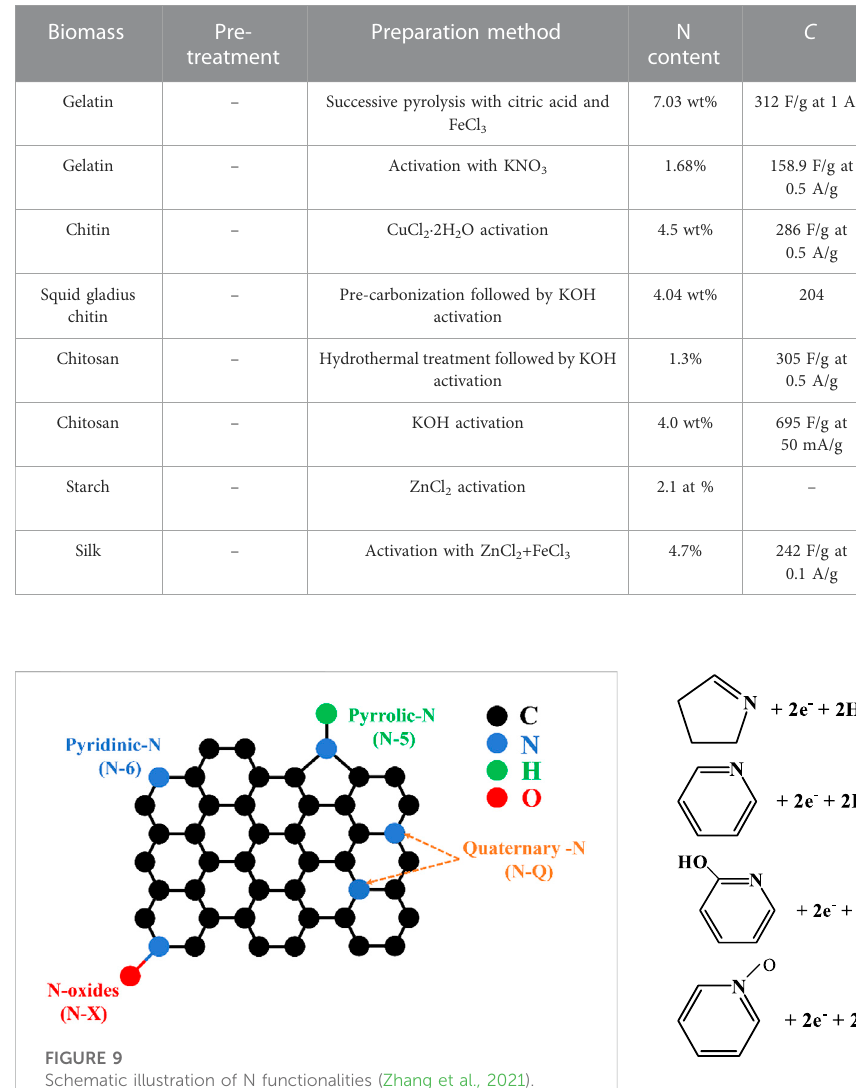
TABLE 8 Other N self-doped biochar applications in supercapacitors.